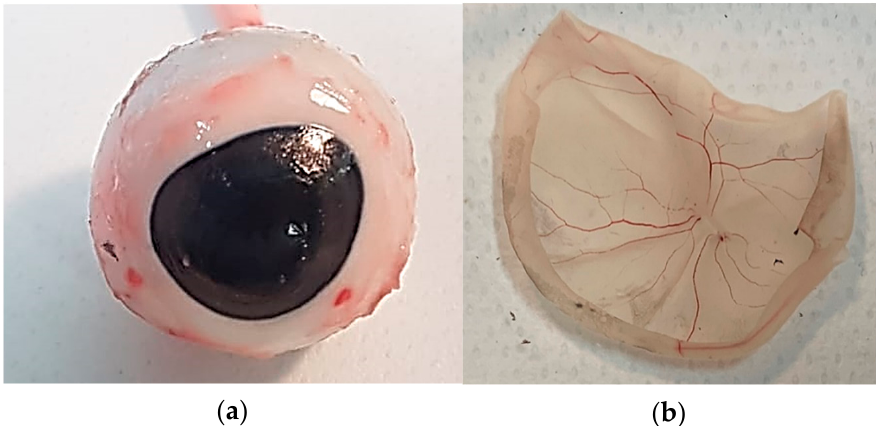
Figure 1. ( a ) Clean eyeball after adipose tissue and conjunctiva removal; ( b ) detached retina preserved in phosphate buffer saline solution (PBS).